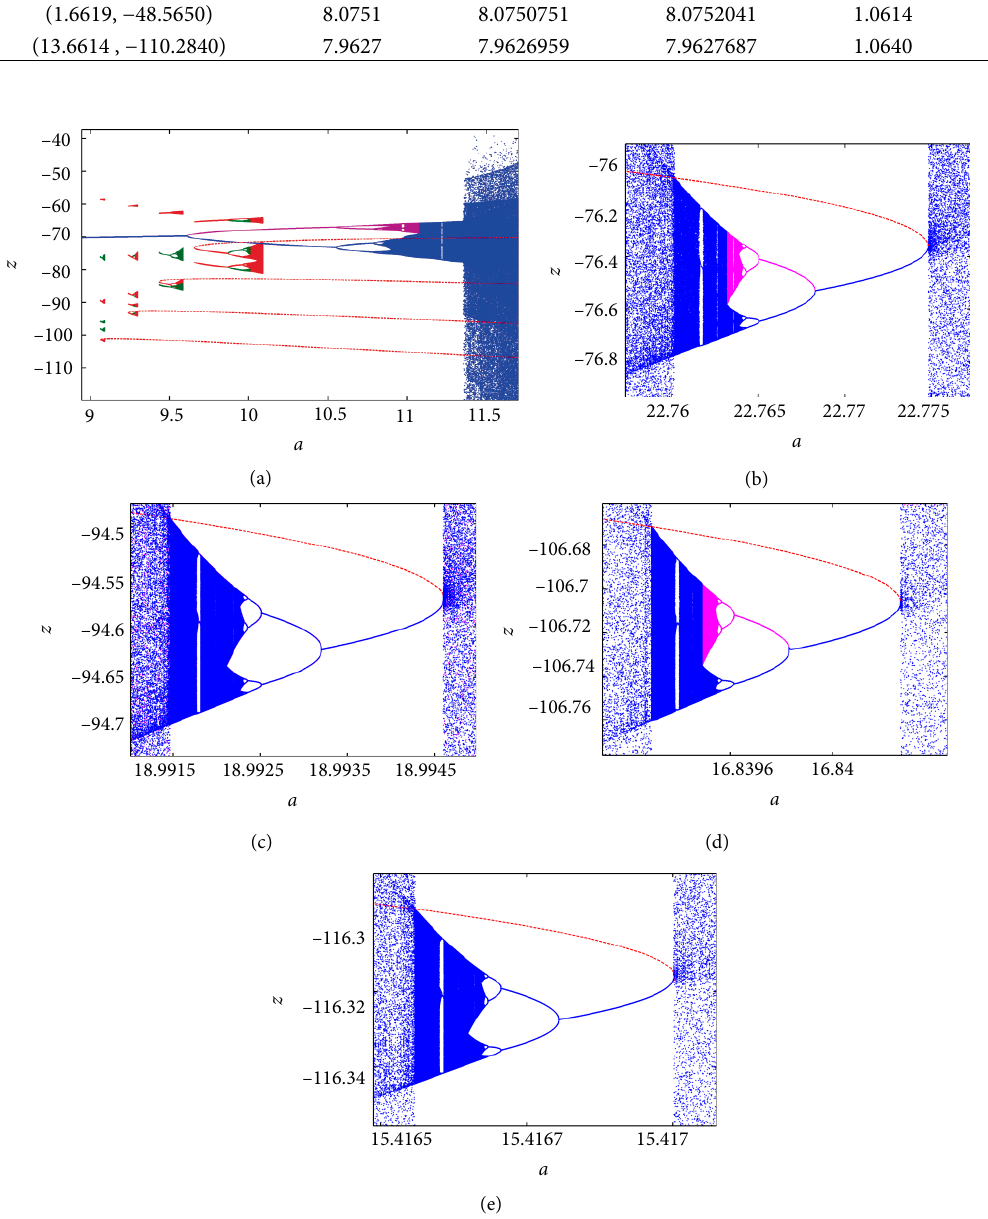
Figure 9: Connections between the sub-branches and the periodic